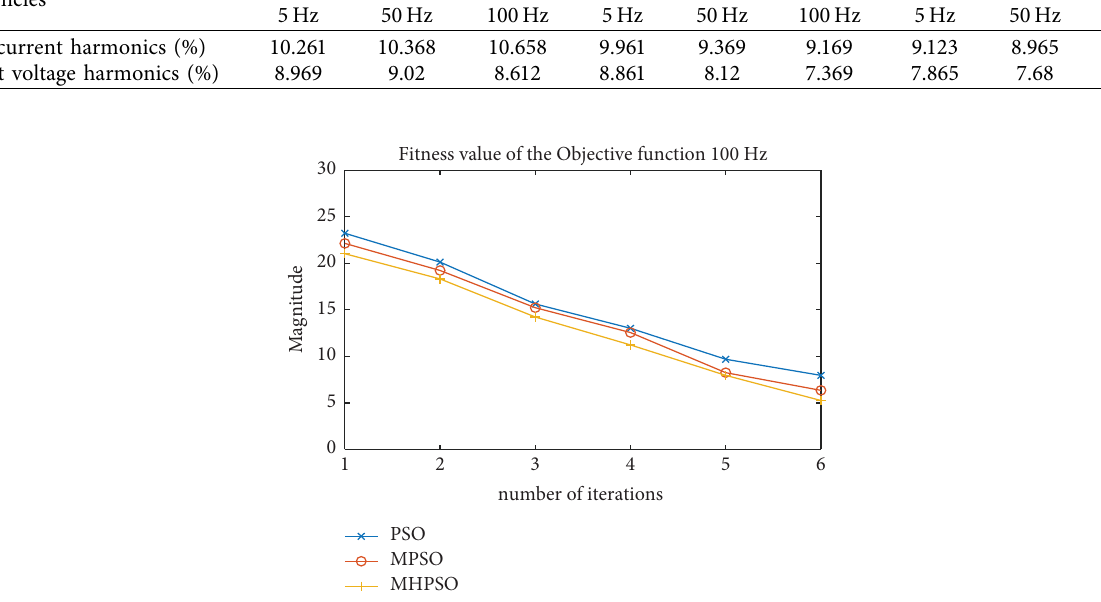
Figure 15: Tree methods ftness value comparison at 100Hz.